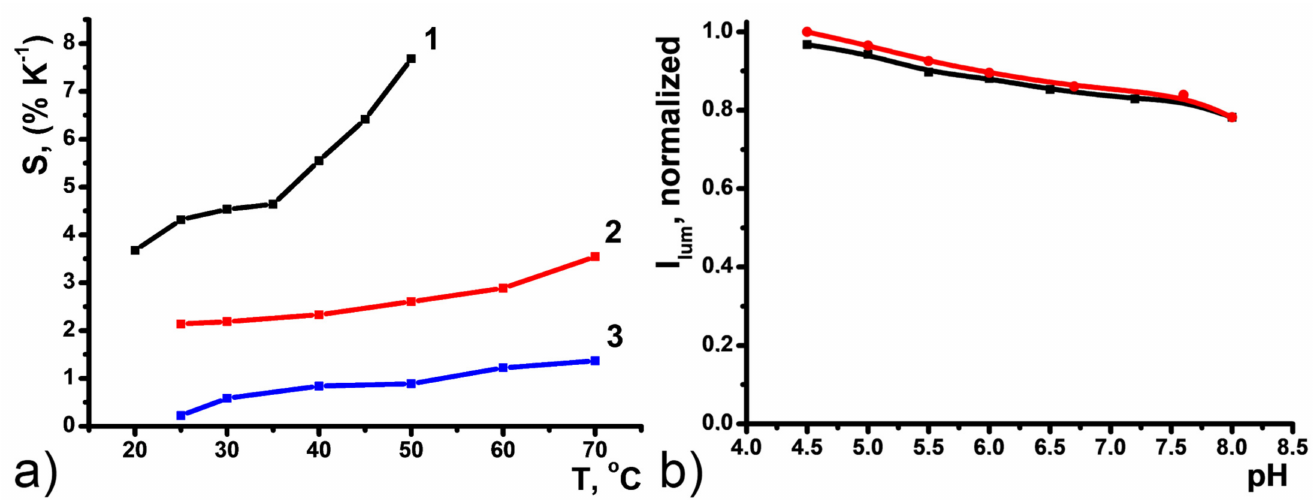
Figure 6. ( a ) Relative thermal sensitivities (multiplied by − 1) for [TbL] + in DMF (1), PSS-[TbL] in H 2 O (2), and CDs in H 2 O (3). ( b ) Normalized luminescence of PSS-[TbL] versus